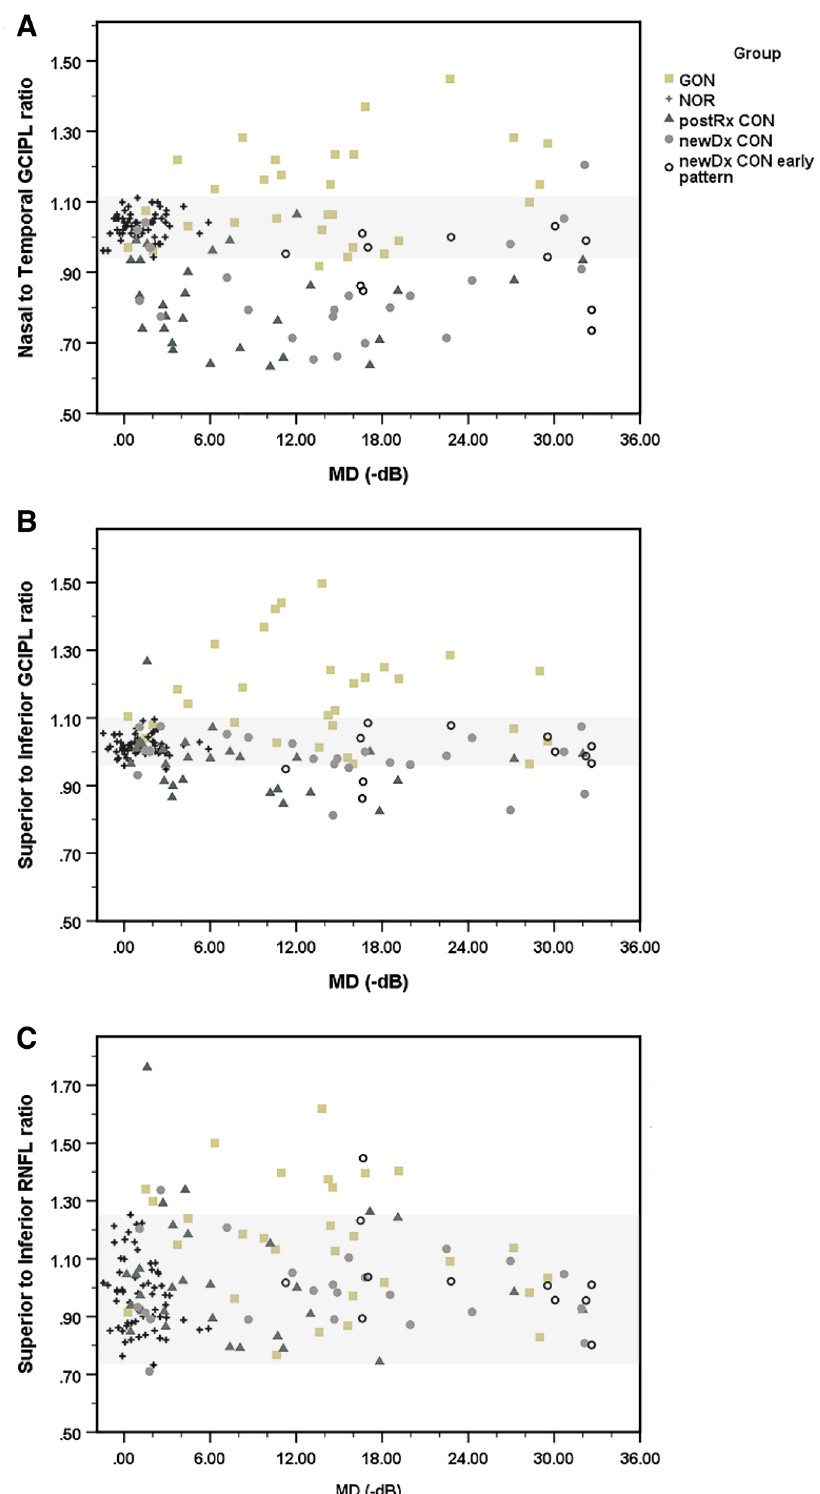
Figure 3. The proposed diagnoses specific thinning pattern of GCIPL and RNFL parameters show high specificities to each diagnosis. Low nasal to temporal macular GCIPL ratio, a characteristic preferential nasal to temporal thinning pattern highly specific to different stages of supra-sellar CON, ( A ) High superior to inferior macular GCIPL ratio, a characteristic preferential inferior to superior thinning pattern highly specific to GON, ( B ) The corresponding superior to inferior RNFL ratio shows poor differentiation between different stages of CON and GON, ( C ) The grey zone indicates the range of which are occupied by healthy control. GON glaucomatous optic neuropathy, CON compressive optic neuropathy, NOR healthy control, postRx post-treatment, newDx CON newly diagnosed CON eyes, newDx CON Early pattern Eleven of 34 newly diagnosed CON eyes show apparent disproportionally milder degree and or earlier pattern of structural thinning compared to the associated visual field losses, RNFL retinal nerve fiber layer, GCIPL ganglion cell-inner plexiform layer, MD mean deviation, dB